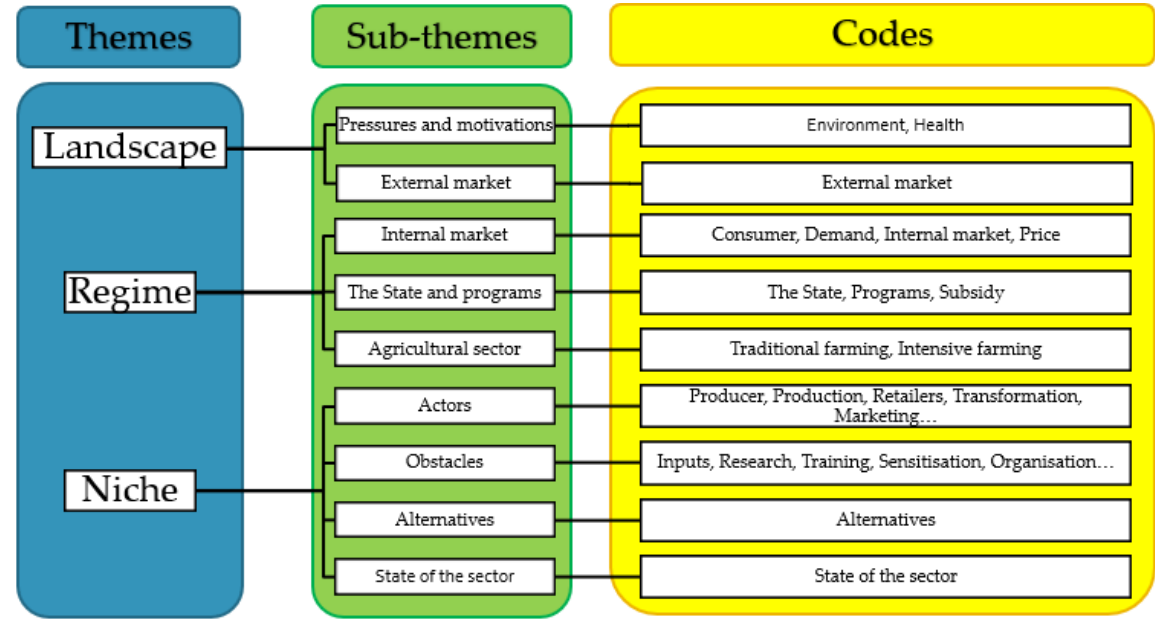
Figure 2. Themes and sub-themes used in thematic analysis. Source: Authors ’